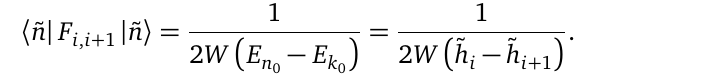
Figure 4: Upper panels: Excess kurtosis κ = ( µ nal matrix elements of (left) 〈 n | F A vanishing excess kurtosis corresponds to a gaussian distribution. Lower panels: Kullback-Leibler divergence of the matrix element distributions with respect to a gaussian with same mean and